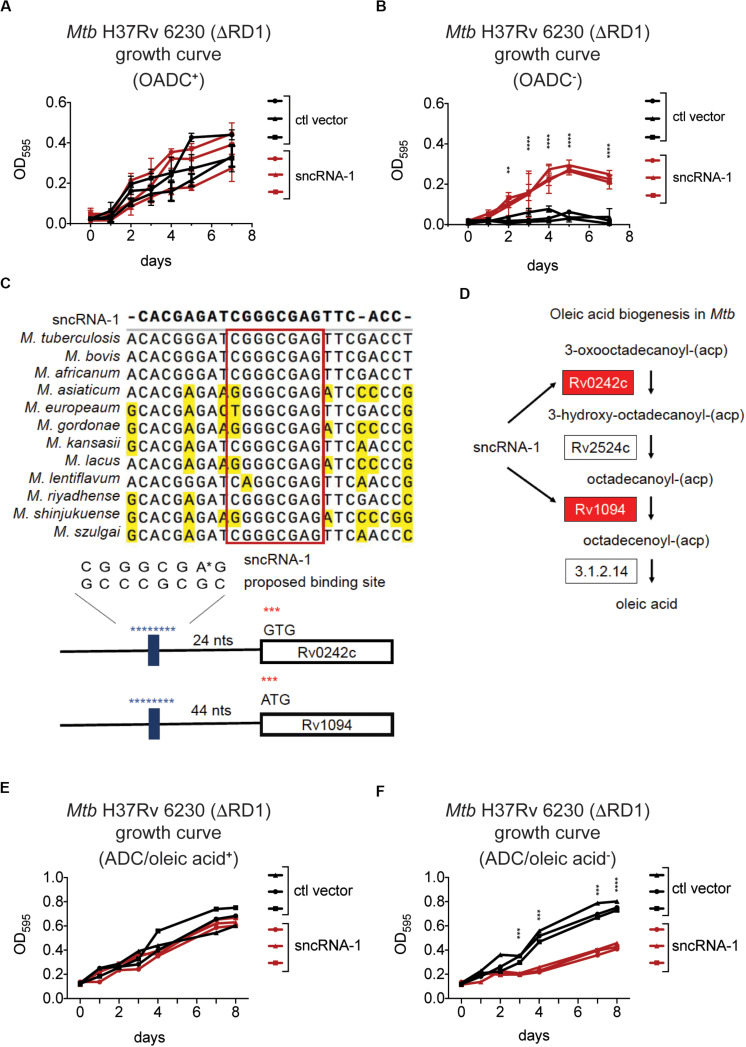
sncRNA-1 improves Mtb growth in oleic acid deficient growth media. (A,B) The fast growing Mtb H37Rv 6230 (lacking endogenous RD1 and sncRNA-1) clones expressing the control vector (black) or the sncRNA-1 vector (red) were grown in pan+ 7H9 media with OADC (A) or without OADC (B) for 7 days. The optical density (OD) at 595 nm was measured every 24 h. p-values are calculated using student t-test with paired two-tailed distribution (∗∗p < 0.01, ****p < 0.0001). (C) sncRNA-1 seed sequence predicted by homology analysis is shown. Proposed sncRNA-1 targets have sncRNA-1 binding site in their 5′ UTR, shown in blue. (D) The oleic acid biogenesis pathway is shown. This was modified from KEGG mycobacterial fatty acid biogenesis pathway available at: https://www.genome.jp/kegg-bin/show_pathway?map00061. Genes that were upregulated when sncRNA-1 was overexpressed in Mtb H37Rv 6230 are shown in red. (E,F)
Mtb H37Rv 6230 clones expressing the control vector (black) or the sncRNA-1 vector (red) were grown in pan+ 7H9/ADC media with oleic acid (E) or without oleic acid (F) for 8 days. The optical density (OD) at 595 nm was measured every 24–48 h. p-values are calculated using student t-test with paired two-tailed distribution (∗∗∗p < 0.001, ****p < 0.0001).